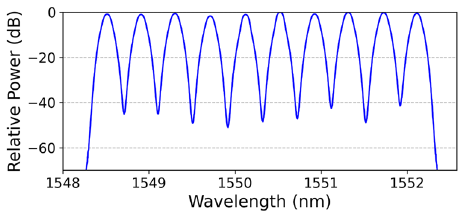
Figure 11: Optical spectra of the WDM signal with 10